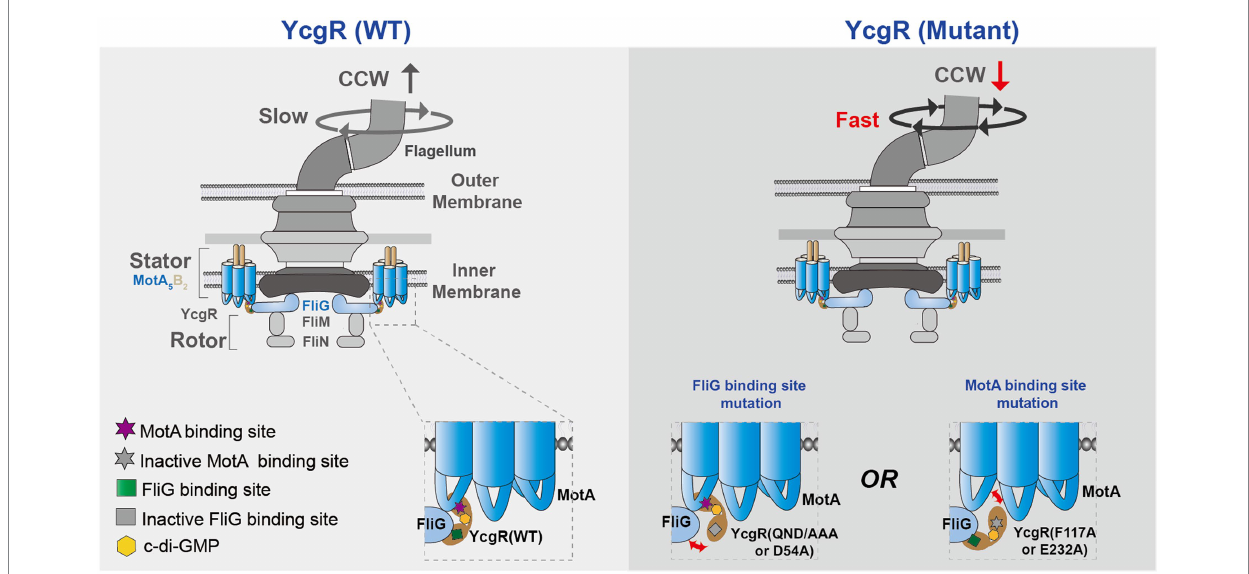
FIGURE 5 A proposed model illustrates the mechanism of how YcgR works. The bacterial flagella motor was shown in a schematic diagram. MotA interacted with FliG via the electrostatic interaction, which generate the torque to drive the flagellar rotation. After being activated by c-di-GMP, YcgR interacted with MotA and FliG to inhibit the flagellar rotation speed and cause a CCW bias. Once the interactions between YcgR and MotA or FliG were weakened by the mutation of MotA or FliG binding residues, the speed was restored, and the CCW ratio